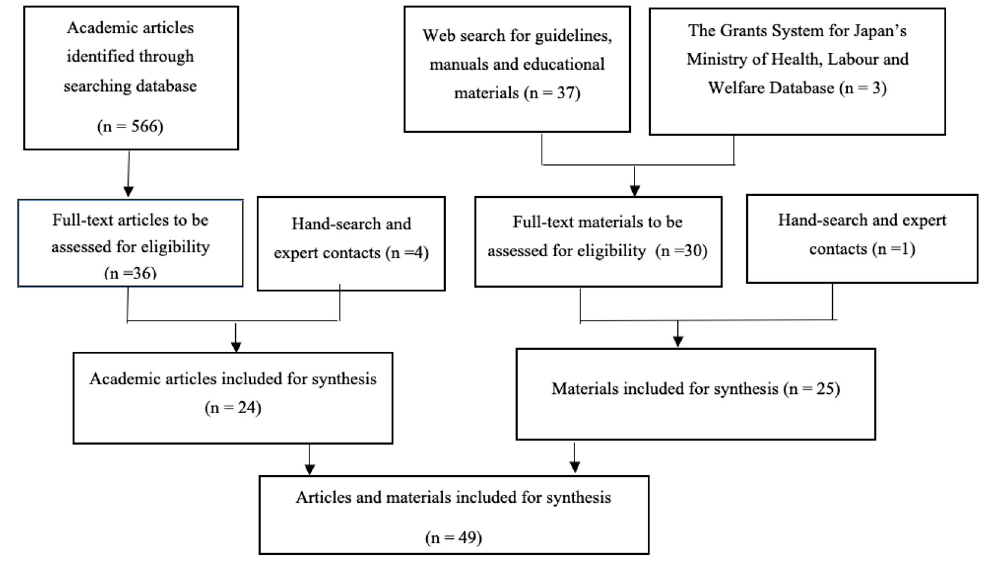
Figure 1. Selection of sources of evidence: academic articles and guidelines, manuals, and educational materials included for synthesis.